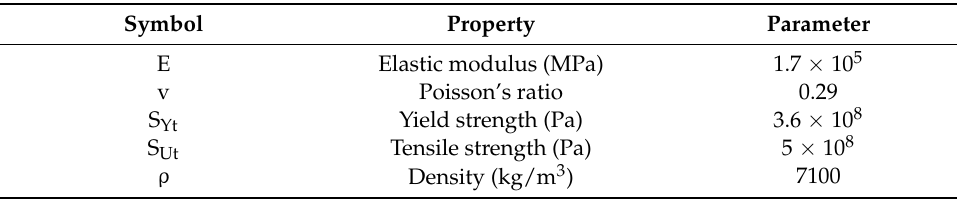
Table 1. Mechanical parameters of ductile iron QT500-10.